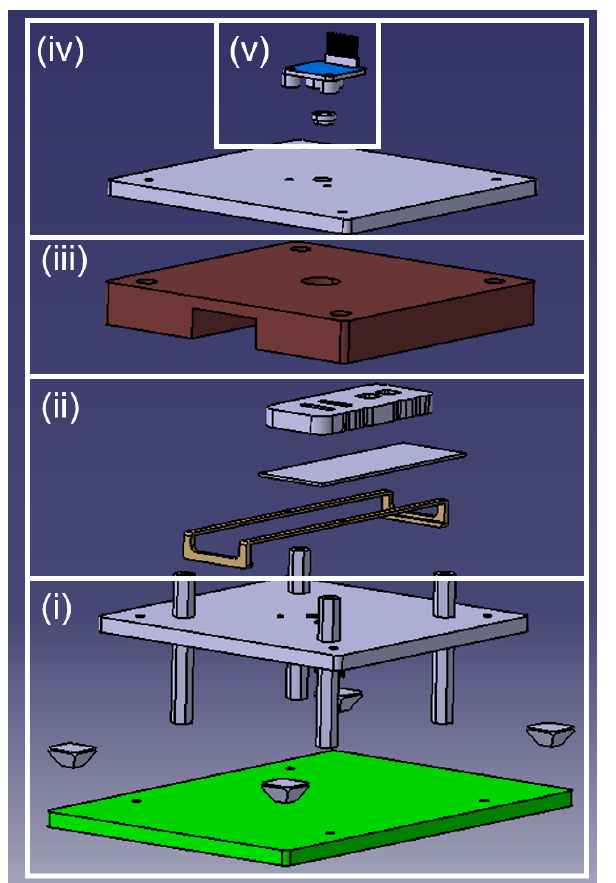
Figure 3. CAD explosion sketch of the optode: (i) base layer for better handling and a solid positioning, (ii) reactor mock-up placed on top of the slide, (iii) placeholder for reactor mock-ups with dif- ferent thicknesses, (iv) top layer and (v) RGB sensor and an incor- porated lens.